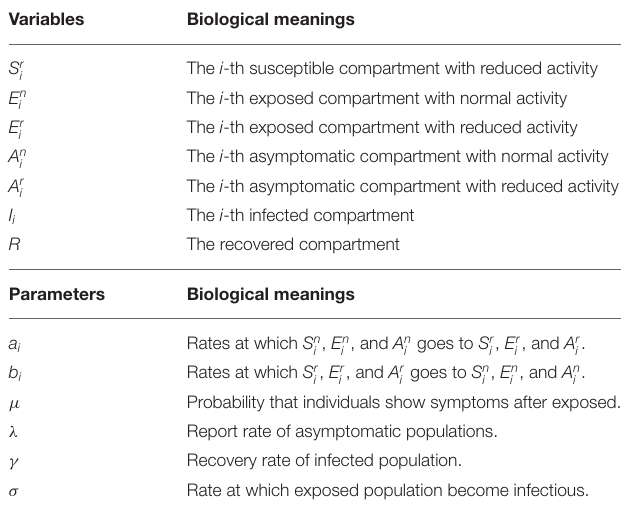
TABLE 1 | Biological meaning of the function and the parameters used in Model